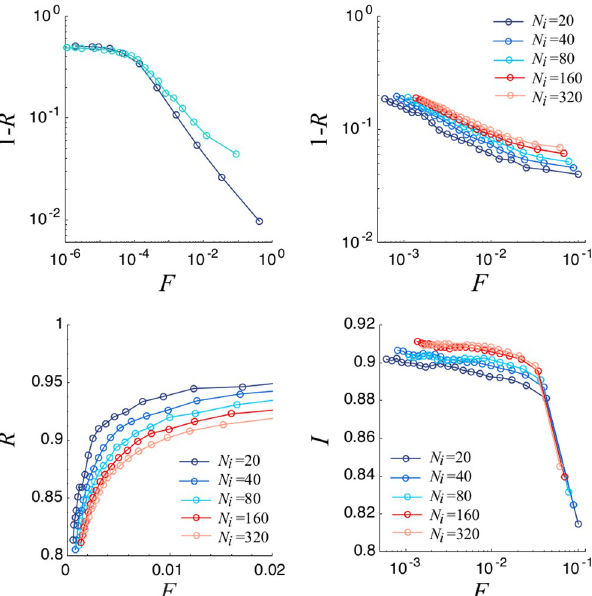
Fig 2. Top: On the left, logarithmic plot of 1 − R versus normalized committee size for the NVR proposed in [1] (dark blue) and the one proposed here ( NVR , light blue) with Ni = 40. On the right, 1 − R versus normalized committee size I for different N i values. Bottom: Representativity (left) and Mean Committee Integrity (right) as a function of normalized committee size. We consider a Erdo¨s-Re´nyi network with N = 10000, h k i = 40 and s 2 ¼ s 2 ¼ 0 : 05 . e p Results are averaged over 100 different realizations.